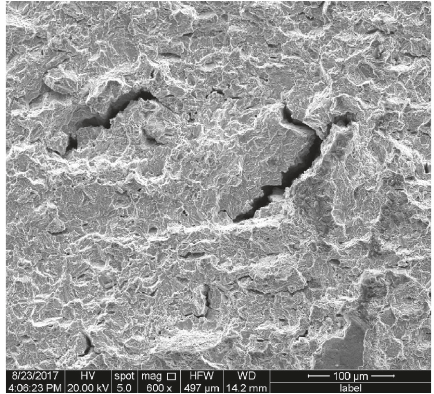
Figure 8: Macromorphology of secondary fracture